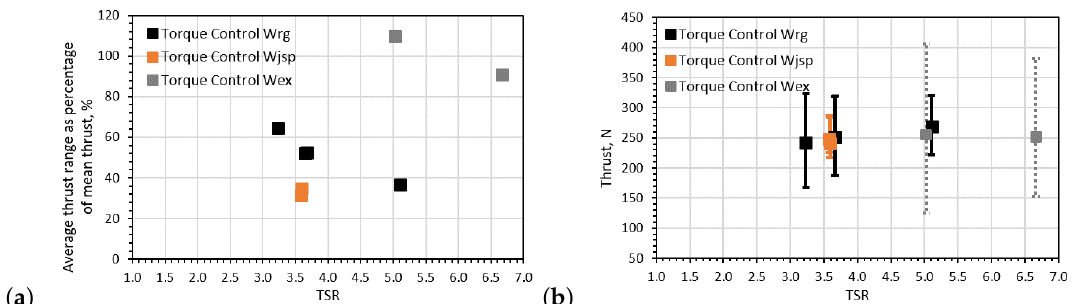
Figure 11. Average rotor thrust fluctuations per wave period only for torque control cases: ( a ) the thrust fluctuation range as a percentage of the mean rotor thrust for each case is presented and ( b ) the average maximum and minimum rotor thrust per wave period are indicated by the extremes of the error bars.